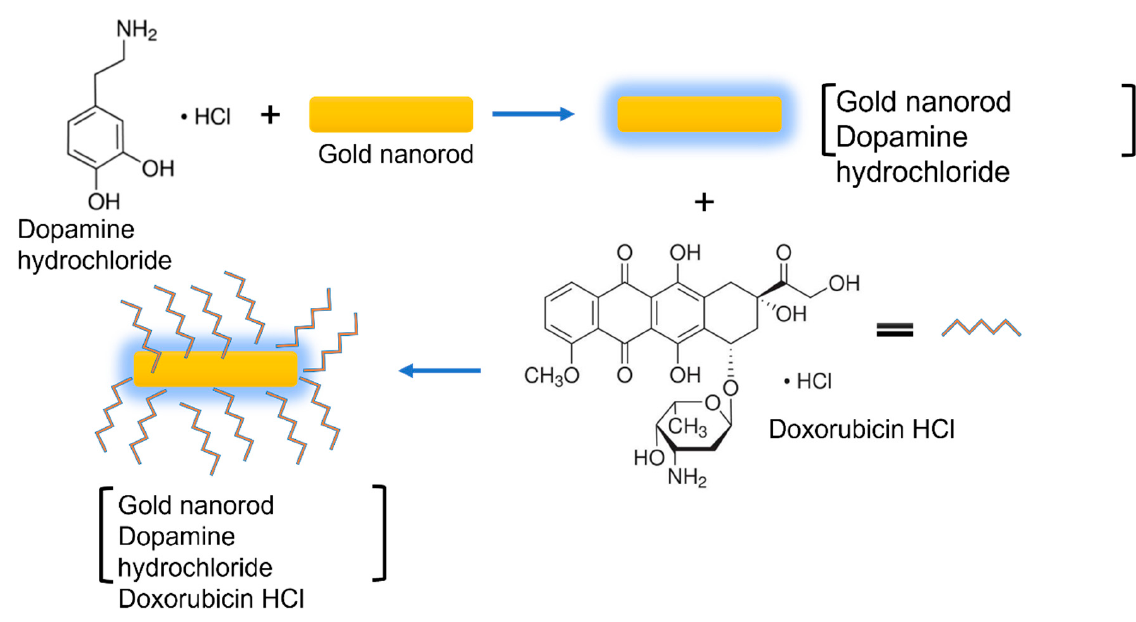
Figure 8. Illustration of the drug loading mechanism.